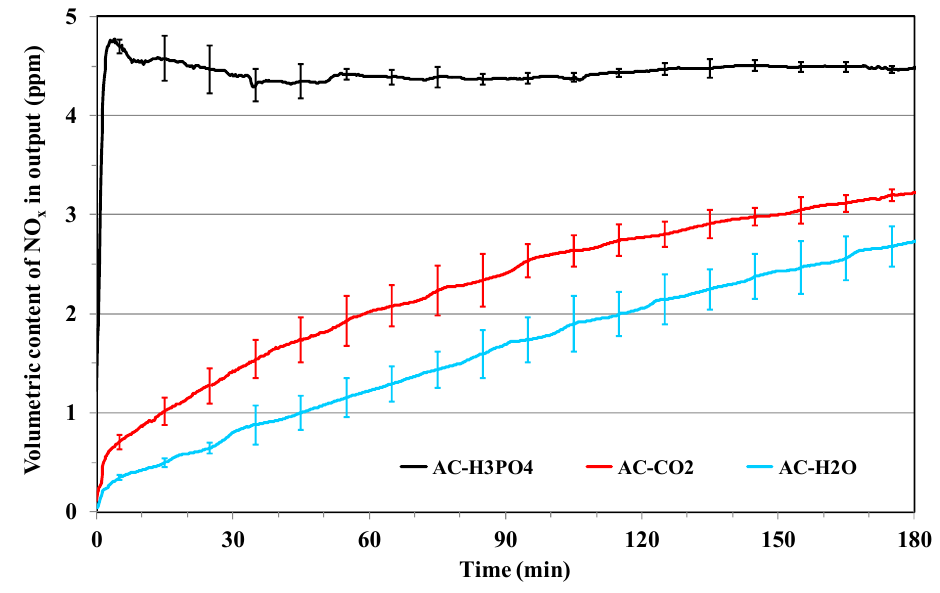
Figure 6. Breakthrough curves of NO x through three differently activated sorbent samples made from olive stones (c 1 NO 2 = 5 ppm, c 1 NO = 0 ppm, 23 ◦ C, 50% RH, v = 0.2 m/s, m Sorb = 2